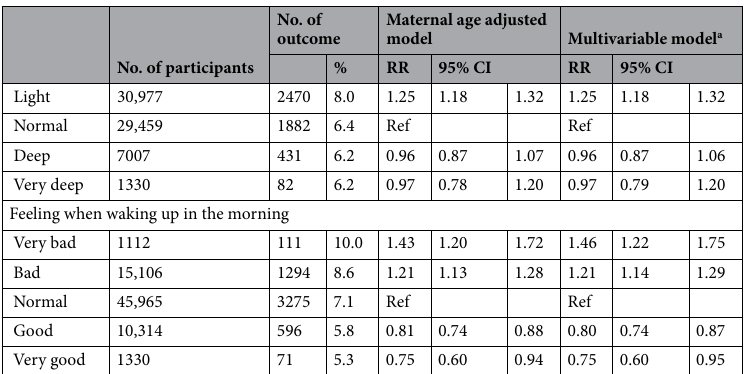
Table 3. Association between sleep during pregnancy and infant sleep, Japan Environment and Children’s Study (2011–2014). CI confidence interval, RR risk ratio. Bold fonts showed the items of infant’s sleep outcomes. a Adjusted for maternal age at delivery, smoking habits, alcohol consumption, pre-pregnancy body mass index, gestational age at birth, parity, infertility treatment, and infant